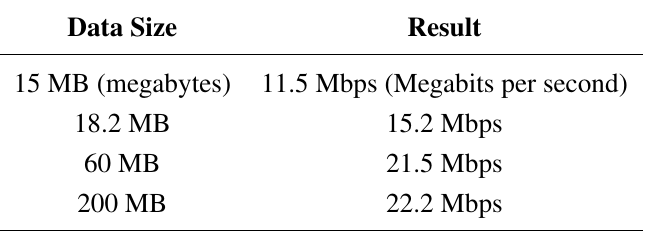
Table 3. Table summarizing results from the throughput test with Raspberry